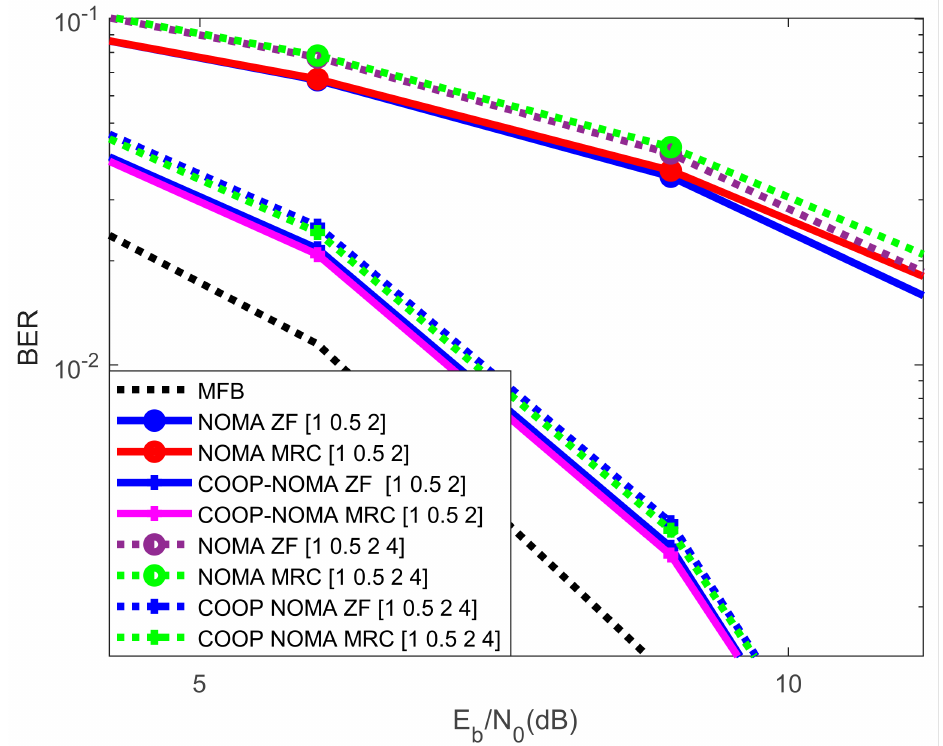
Figure 7. Results for 3 and 4 NOMA users, with 8 × 64 MIMO, with LDPC